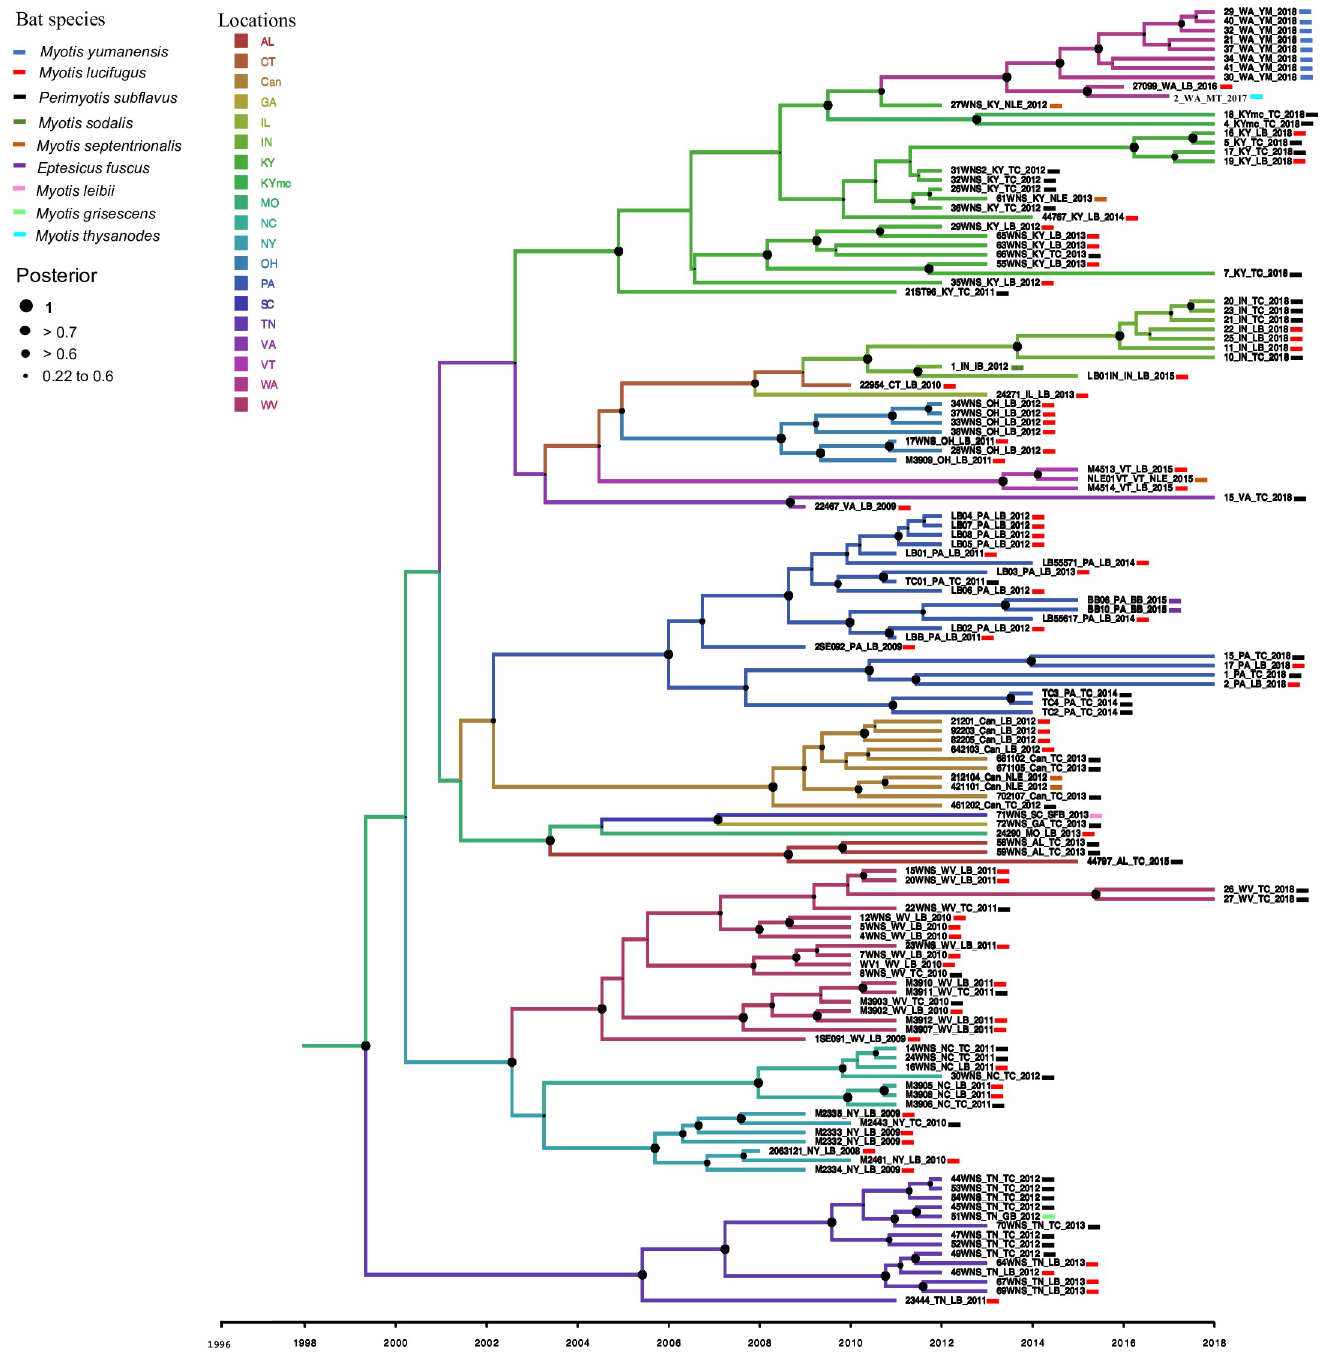
Fig 1. Strict clock phylogeographic tree constructed from the coat protein sequence of 139 PdPV-pa isolates in BEAST v2.5. The tree is annotated with colors coded for the locations that included 17 US states and New Brunswick, Canada. Standard abbreviations of US states are used in the figure legend except “Can” for New Brunswick province of Canada and “KYmc” for Mammoth cave locations in Kentucky. Bat species are notes according to the legend. Nodes of the tree are denoted by solid black circles and the size of the circle corresponds to posterior supports shown in the top legend. Branch lengths are in time, depicted by a horizontal time-scale and the branch thickness corresponds to posterior values. For a detail description of the virus isolate ID, refer to Table 1.